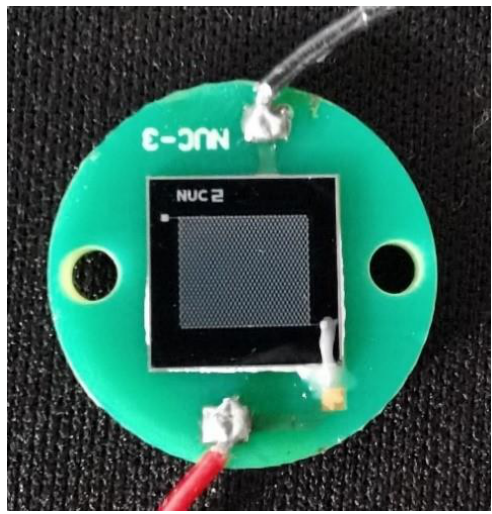
Figure 4. Photograph of the CMUT glued and wire-bonded to the printed circuit board (PCB).